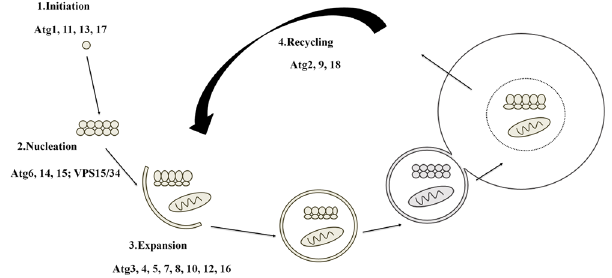
Figure 2. Schematic representation of autophagy in P . sojae . According to the distribution of ATGs in P . sojae , autophagy divided into 4 steps, as it is in H . sapiens : initiation of autophagy, vesicle nucleation at the PAS, vesicle expansion and recycling.